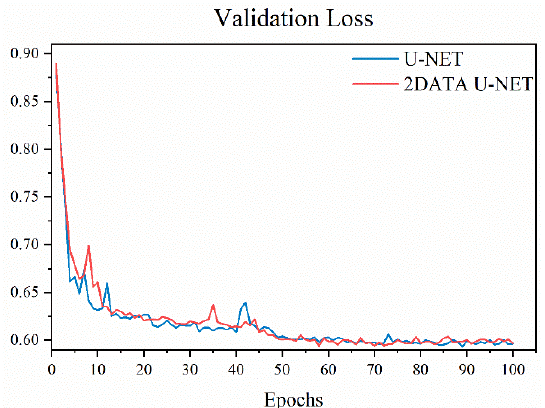
Figure 9. Comparison of validation loss of mono-temporal images and multi-temporal images (Y-axis: the value of the validation loss in training process).